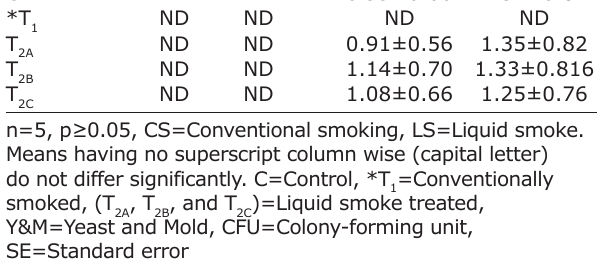
SE=Standard error